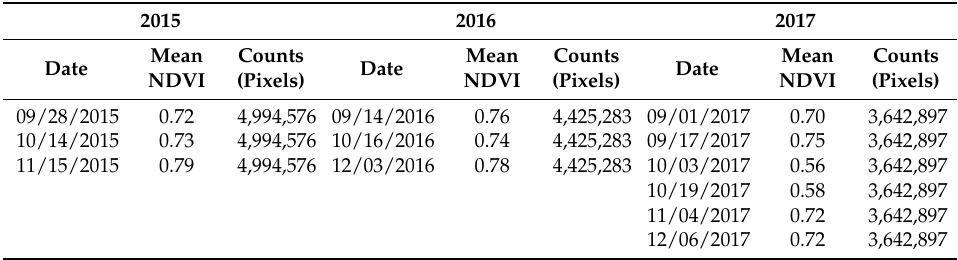
Table 5. The changes in NDVI for Puerto